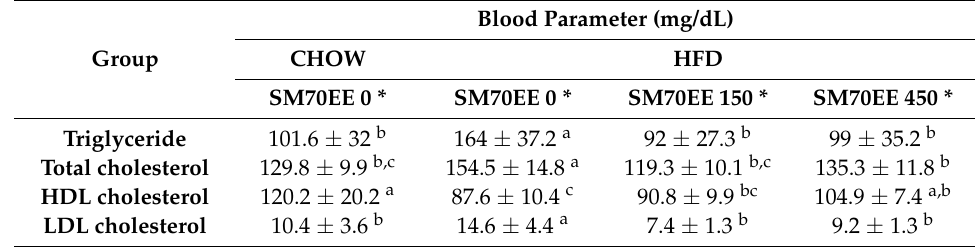
Table 4. Effect of supplementation with SM70EE on blood lipid levels in HFD-induced obese mice. Group